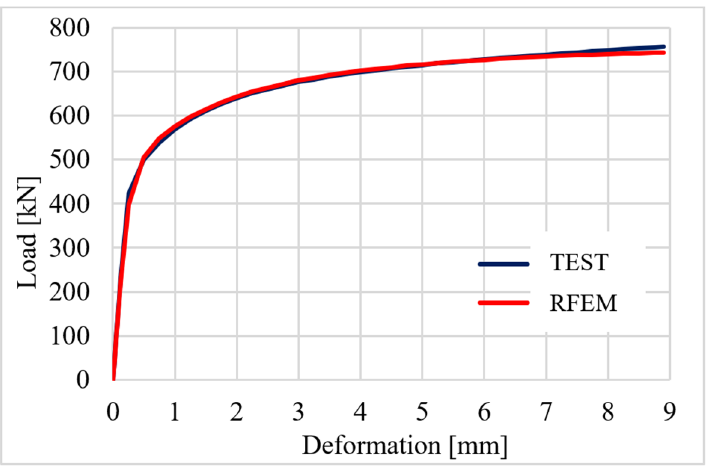
Figure 11. Load vs. deflection curve, RFEM and experimental curves of specimen T2.